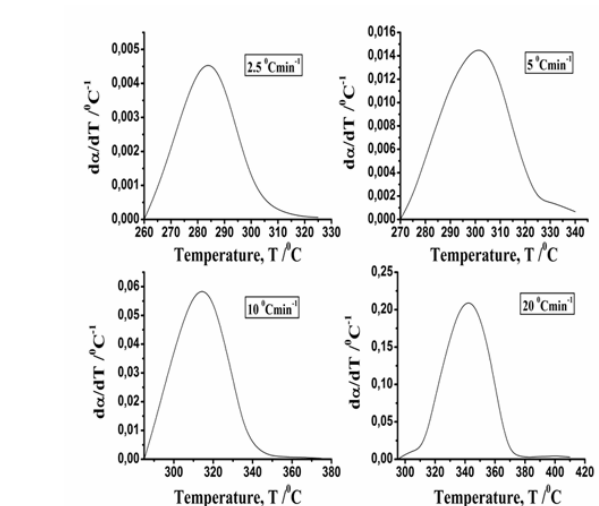
Figure 2 – Experimental differential conversion (d α /dT vs. T) curves for the reduction pro- cess of nickel oxide samples prepared by the gel-combustion method under hydrogen atmosphere, at different heating rates (v h = 2.5, 5, 10 and 20 0 Cmin -1